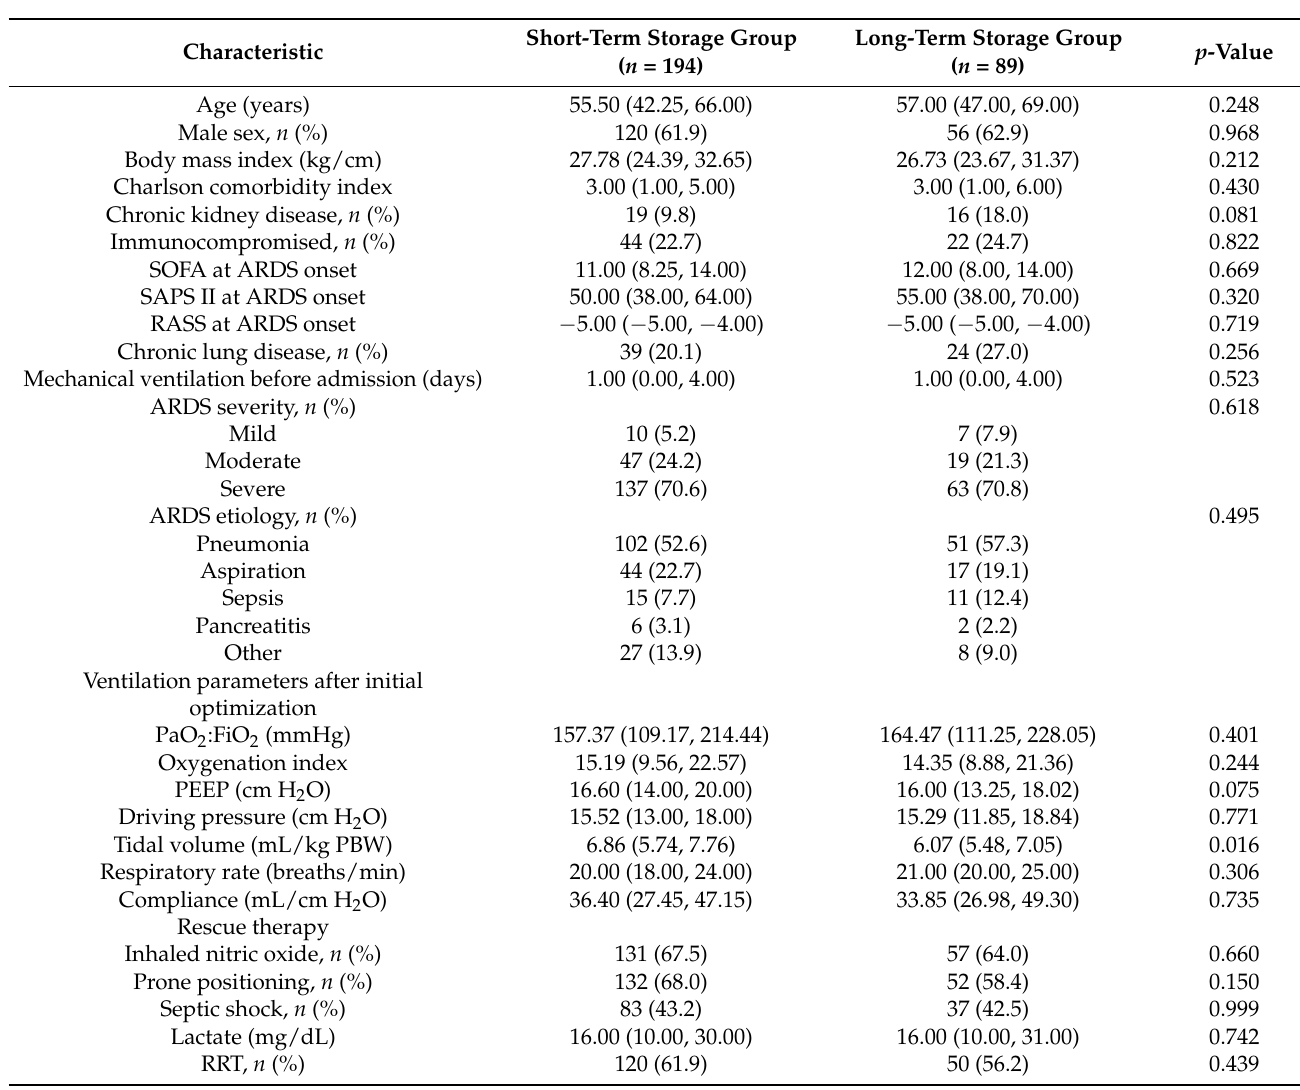
Table 1. Characteristics of the